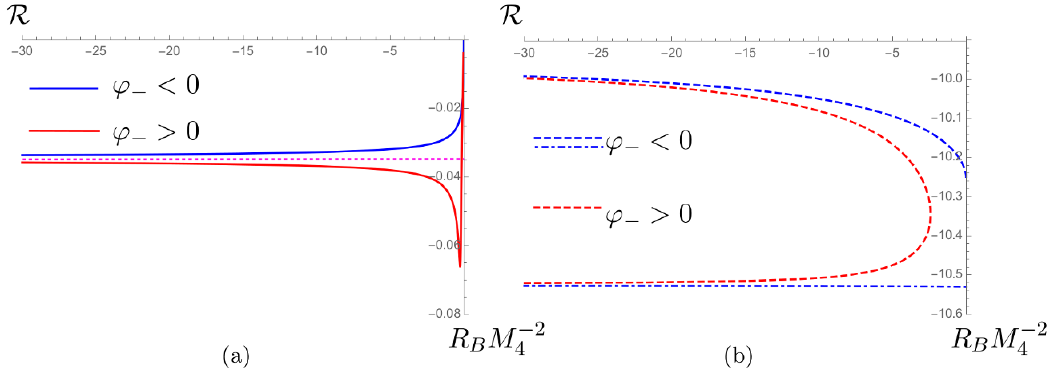
Figure 13 . Brane curvature in 4d Planck units R B M (cid:0) 2 vs. R with R < 0 for bulk potential (3.1), 4 brane quantities (3.2) and parameter values (3.3). In (cid:12)gure (a) we show results corresponding to the branches denoted by solid lines in (cid:12)gure 10. In (cid:12)gure (b) the results for the dashed and dot-dashed branches in (cid:12)gure 10 are